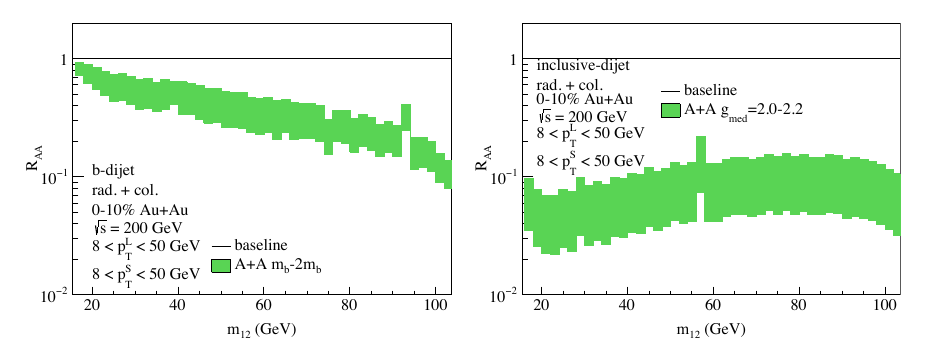
Figure 3. Nuclear modification factor R AA with respect to dijet invariant mass m 12 for b-tagged (left) and inclusive Figure 2. The dijet imbalance z J distributions for b-tagged (left) and inclusive (right) dijet production at √ s NN = (right) dijet production in Au + Au collisions at √ s NN = 200 GeV for sPHENIX at RHIC. Left: we fix g med = 2 . 0 200 GeV with sPHENIX kinematics. The black histogram marks the distribution for p + p collisions, while and the band corresponds to varying the mass of the propagating system from m b to 2 m b . Right: the band the green marks that of Au + Au collisions. The blue “data” points come from preliminary simulations by the corresponds to the range of medium couplings g med = 2 . 0 sPHENIX collaboration [10]. Left: the coupling of the jet to the medium is fixed at g med = 2 . 0 and the band corresponds to varying the range of masses of the propagating system between m b and 2 m b . Right: the band corresponds to varying the medium coupling g med = 2 . 0 2 . 2. −